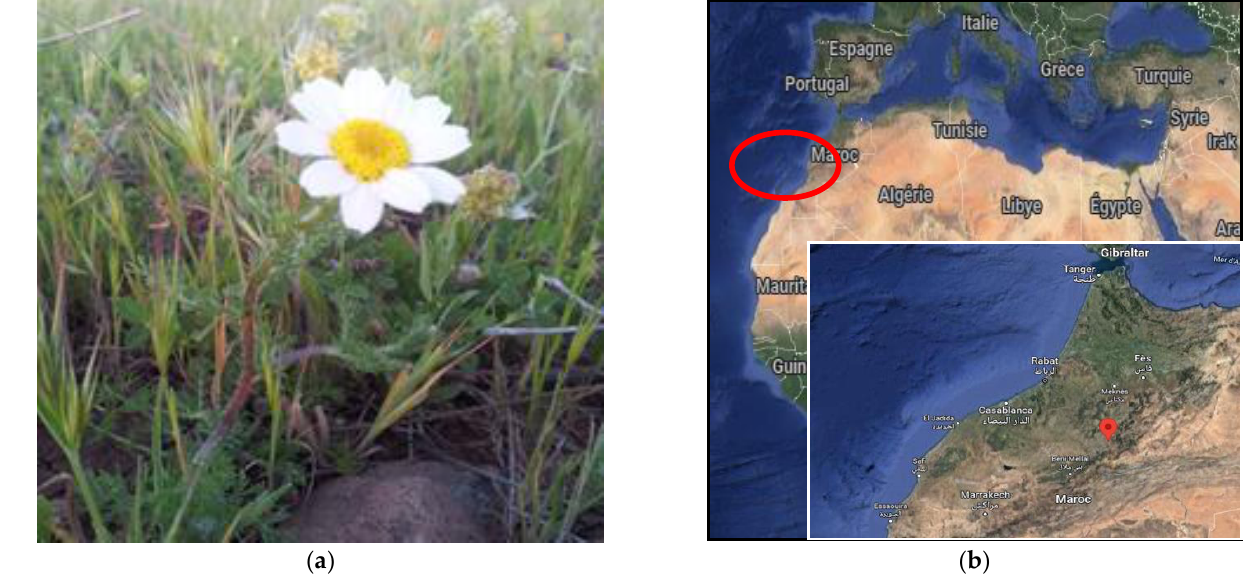
Figure 3. ( a ) Picture of Anacyclus clavatus and ( b ) localization of the site of harvest.